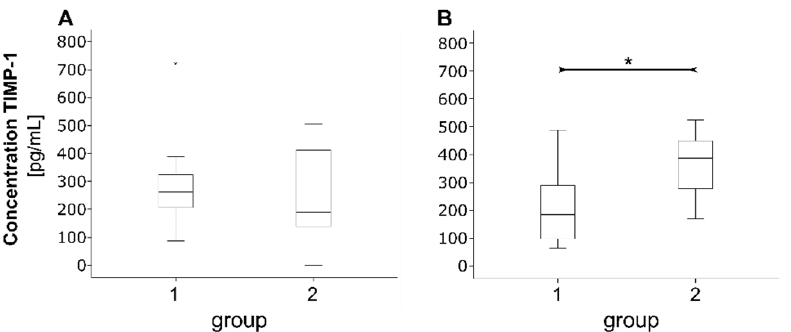
Figure 4. Boxplots showing the concentration of TIMP-1 concentration in group 1 (BD, GP) and group 2 (PB, SE) at visit 1 ( A ) and visit 2 ( B ). * Mann–Whitney U test ( p = 0.064).